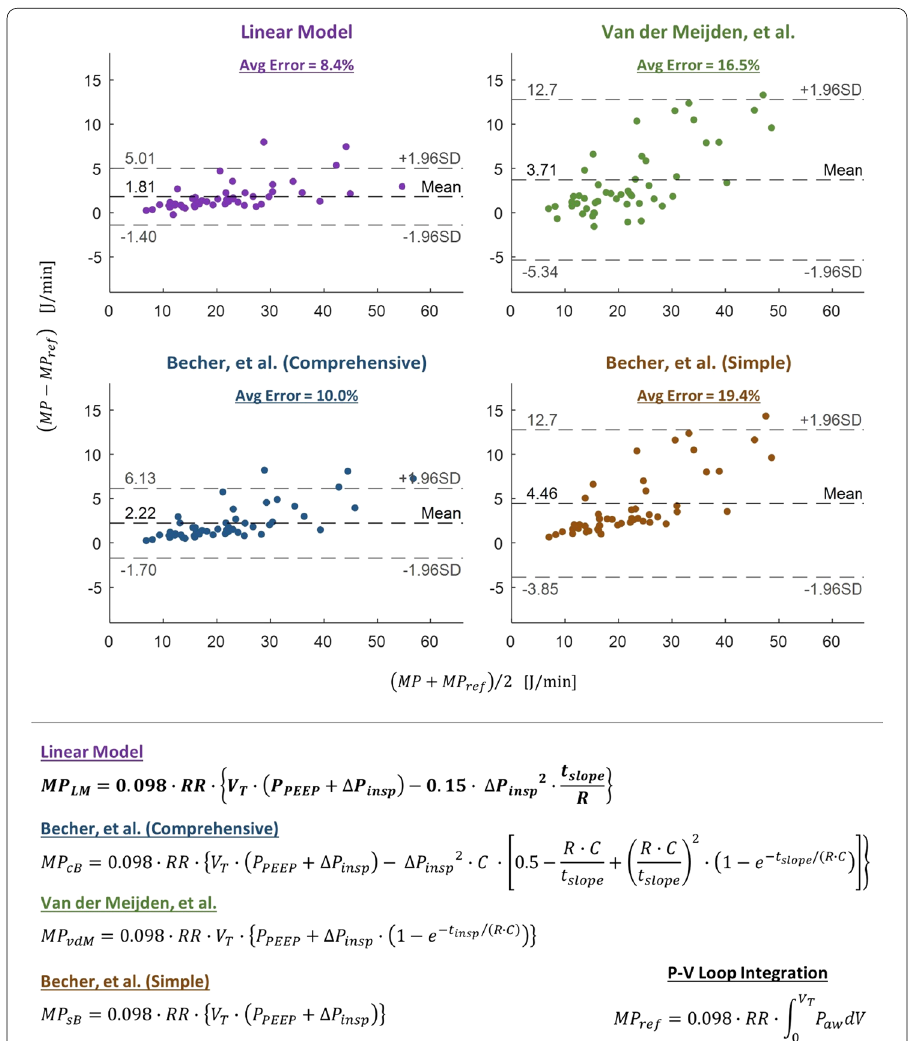
Fig. 1 Four equations for estimating mechanical power in PCV patients (bottom), and Bland–Altman plots for each of these equations [4, 5] (top). Bland–Altman plots were generated by plotting the mean of the calculated value (MP) and the numerically integrated value (MP ref ) for each equation ( x -axis) against the difference between the calculated value and numerically integrated value ( y